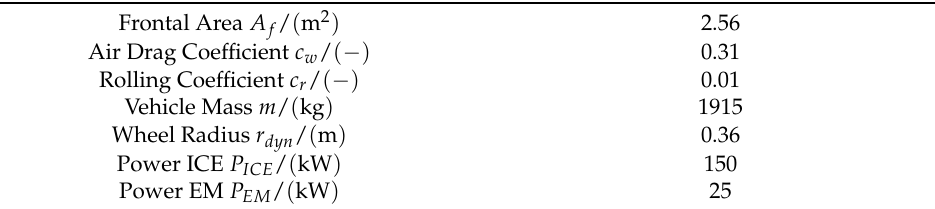
Figure 2. Topologies of HEVs in parallel configuration. Table 1. Parameters of investigated SUV